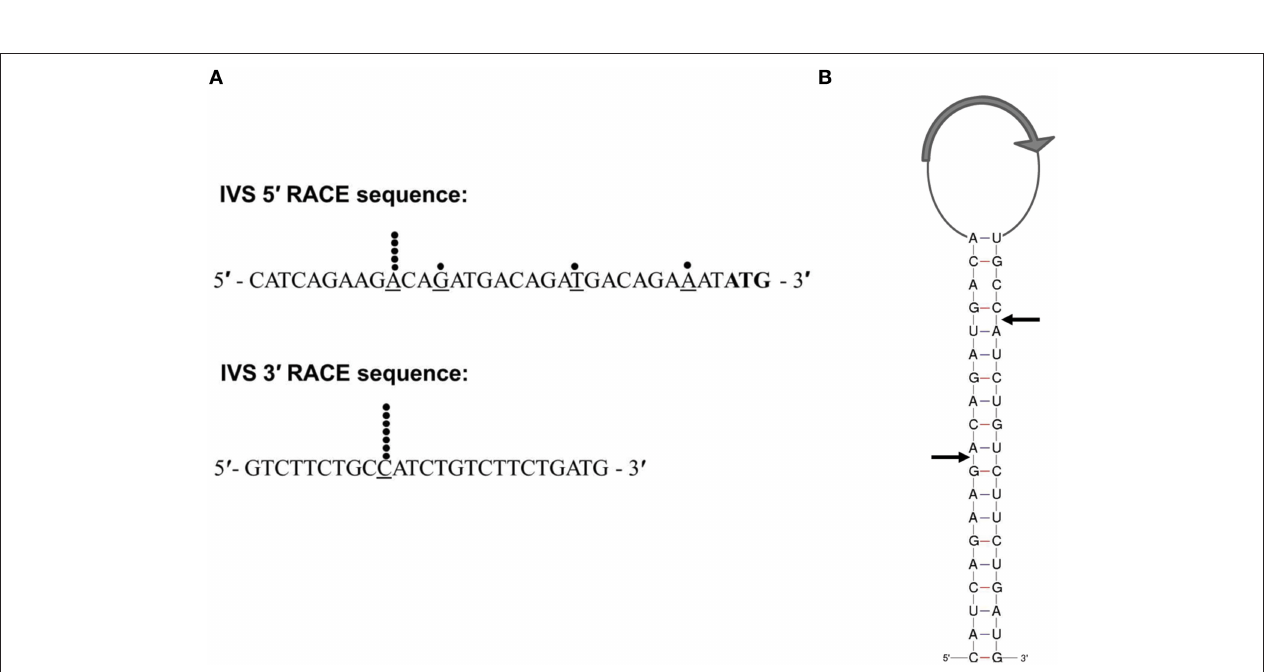
FIGURE 3 | Characterization of IVS termini by 5 ′ - and 3 ′ -RACE analysis. (A) Sequences of the 5 ′ and 3 ′ ends of the IVS are shown. Black dots indicate the last base (underlined) in an individual sequence analysis of a cloned RACE PCR product. The predicted start codon of the S23p ORF is shown in bold font. (B) Schematic representation of RNase III processing sites on the stem of the IVS RNA of C. burnetii (RSA 493). Black arrows indicate processing sites as determined by 5 ′ - and 3 ′ -RACE analyses. The relative location of the S23 ORF (CBU_2096) is indicated by a large gray arrow in the loop.